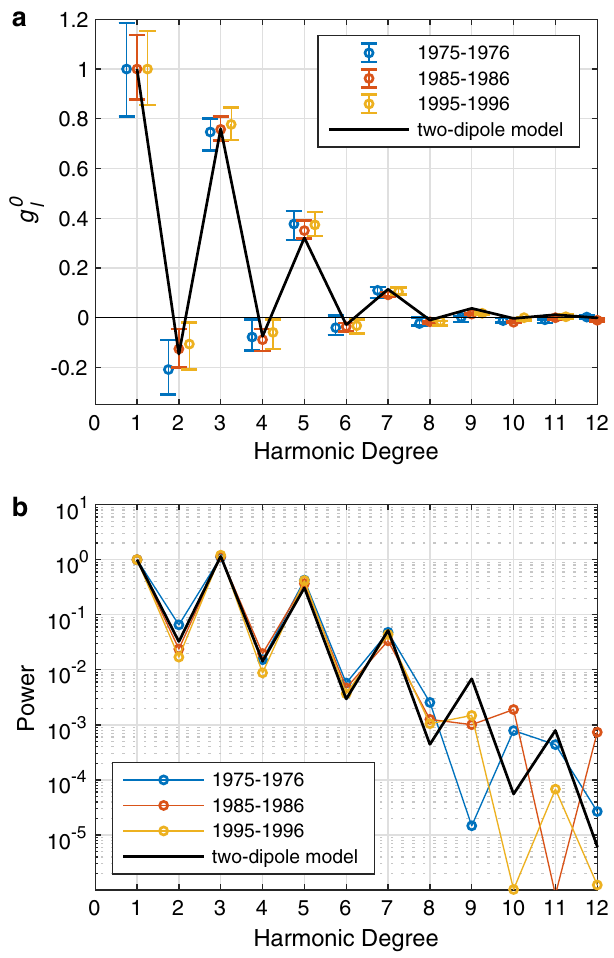
Fig. 2. Spherical harmonic structure of the photospheric magnetic fi eld. (a) Normalized zonal Gauss coef fi cients of the photospheric magnetic potential for three consecutive solar minima. The two- dipole model obtained from the fi rst four Gauss coef fi cients is shown in black. (b) Normalized zonal spatial power spectra of the photospheric magnetic fi eld for the same solar minima as in panel a, showing the relative contributions of the different harmonics (multipoles) to the total power.